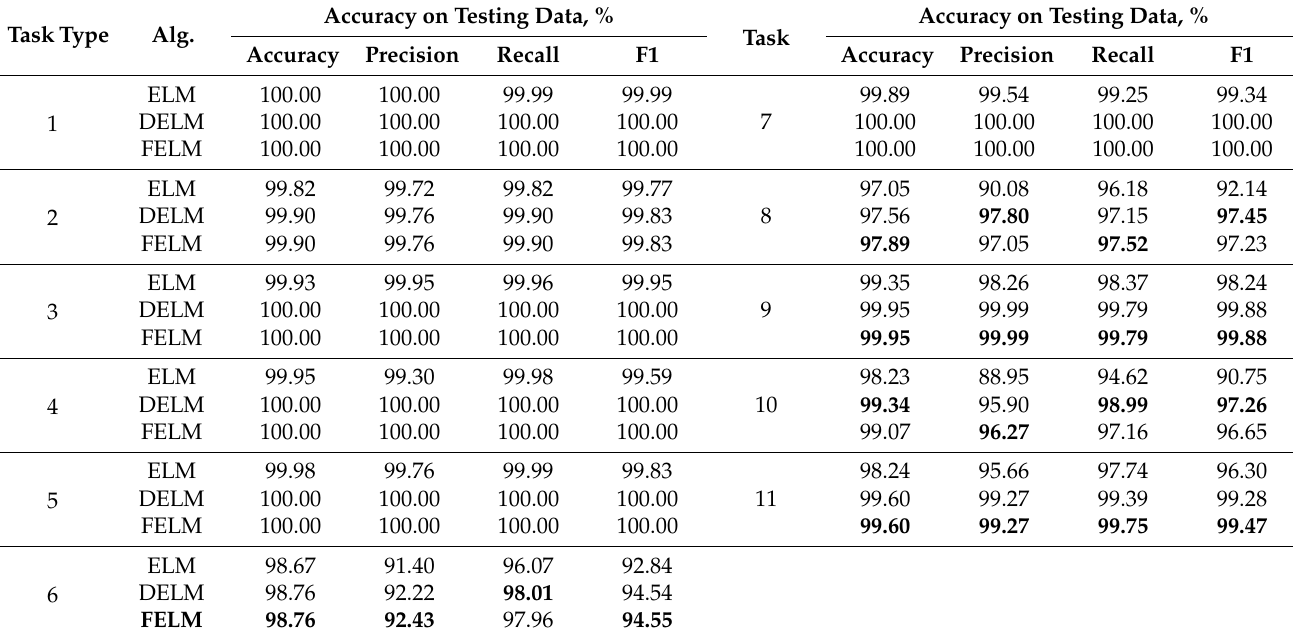
Table 7. Accuracy comparison of ELM, DELM (tuned with DE), and FELM (tuned with ETFSS).